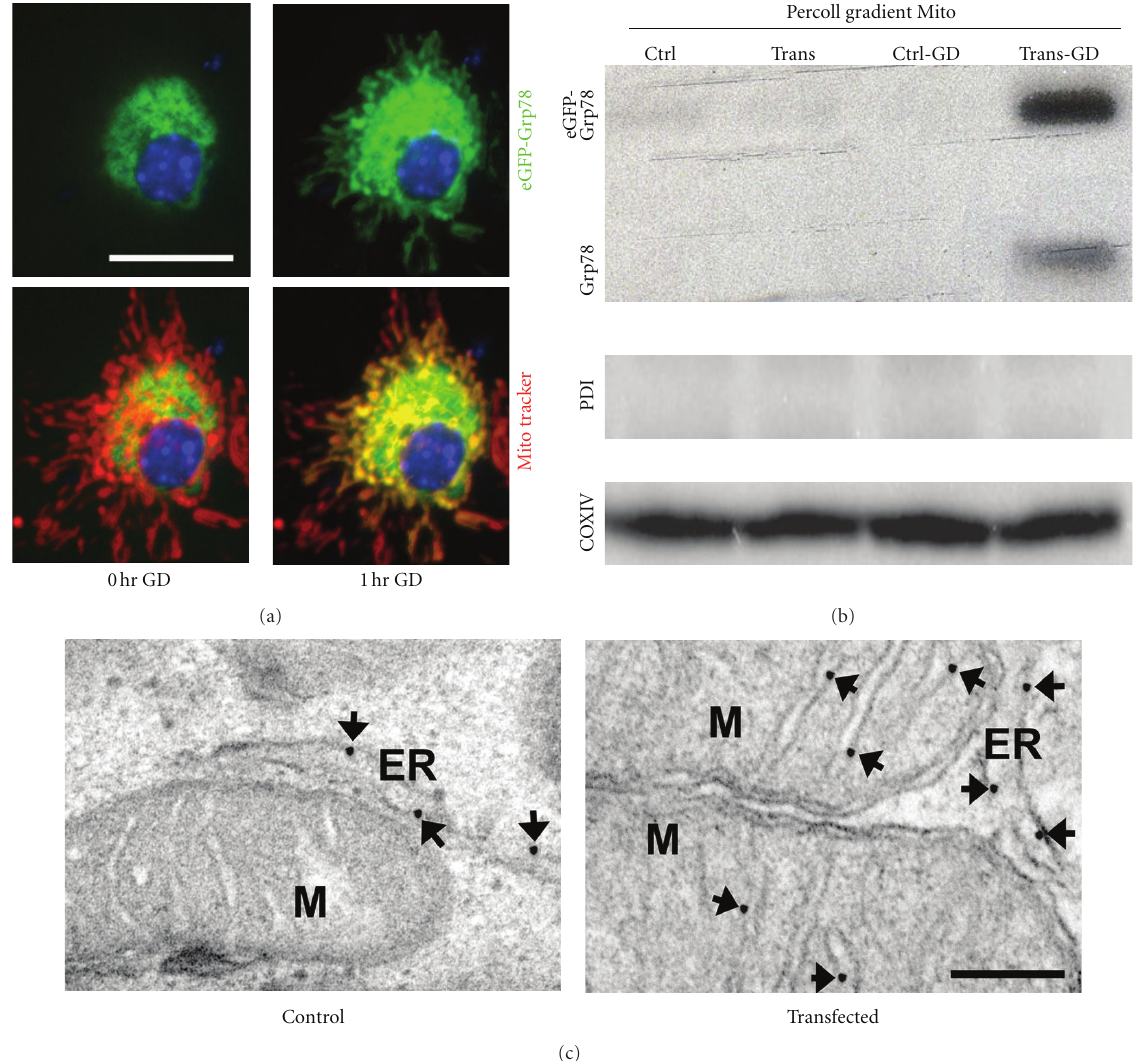
Figure 2: GRP78 retargets to mitochondria with glucose deprivation (GD). (a) Fluorescence photomicrographs were taken before and after 1hr GD. Under normal conditions, the green fluorescence in eGFP-Grp78 transfected cells shows the normal perinuclear ER localization. After 1 hr GD this changes to a di ff use cytoplasmic pattern overlapping with the mitochondrial distribution visualized by partial overlap with Mito-tracker (red) fluorescence. Overlap is yellow. (b) After 3hr GD, mitochondria were purified and analyzed by Western blotting using antibodies against GRP78, PDI (an ER-specific marker), or COXIV (a mitochondrial marker). The purified mitochondria do not show contamination with ER marker PDI but do have GRP78. Ctrl: control. Trans: transfected. (c) Submitochondrial localization of GRP78 in control and GD-stressed cells by immunoelectron microscopy. Arrows point to the localization of GRP78. The gold particles were associated exclusively with ER membrane in control cells (left panel). In contrast, immune-EM staining shows GRP78 within mitochondria from 3hr GD-stressed cells, demonstrating significant mitochondrial labeling, with grains mainly decorating the inner mitochondrial membrane (right panel). M, mitochondrion. Scale bars,